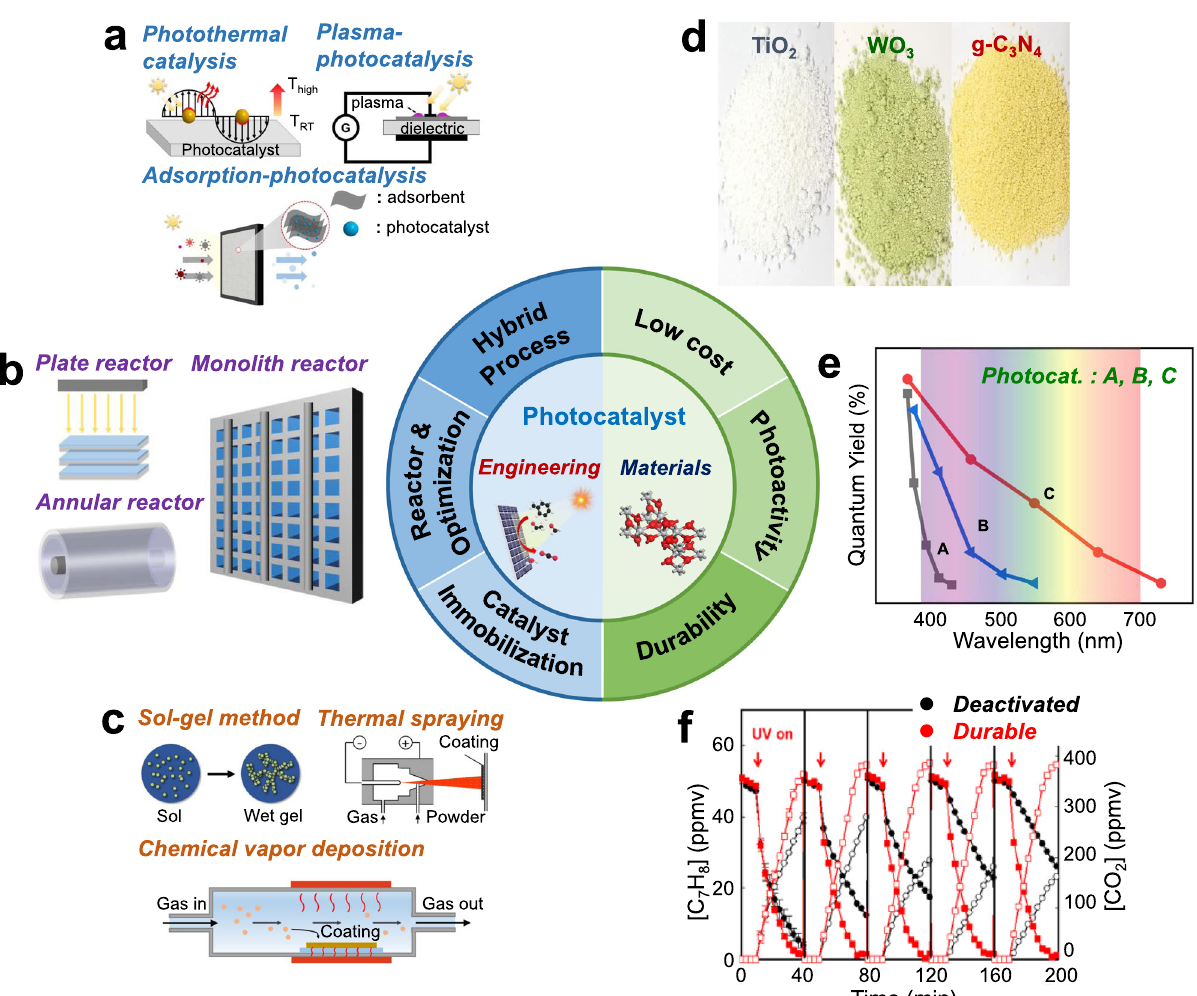
Fig. 1 Holistic approach to the practical applications of photocatalytic air puri fi cation with considering various engineering and materials aspects. a hybridization of photocatalysis with other technologies, b photocatalytic reactor development, c photocatalyst immobilization methods, d low-cost photocatalytic materials, e photocatalytic activities as a function of the wavelength, f durability of photocatalysts against deactivation and fouling. This fi gure content is adapted with permission from Weon et al. 4 Copyright (2018) American Chemical